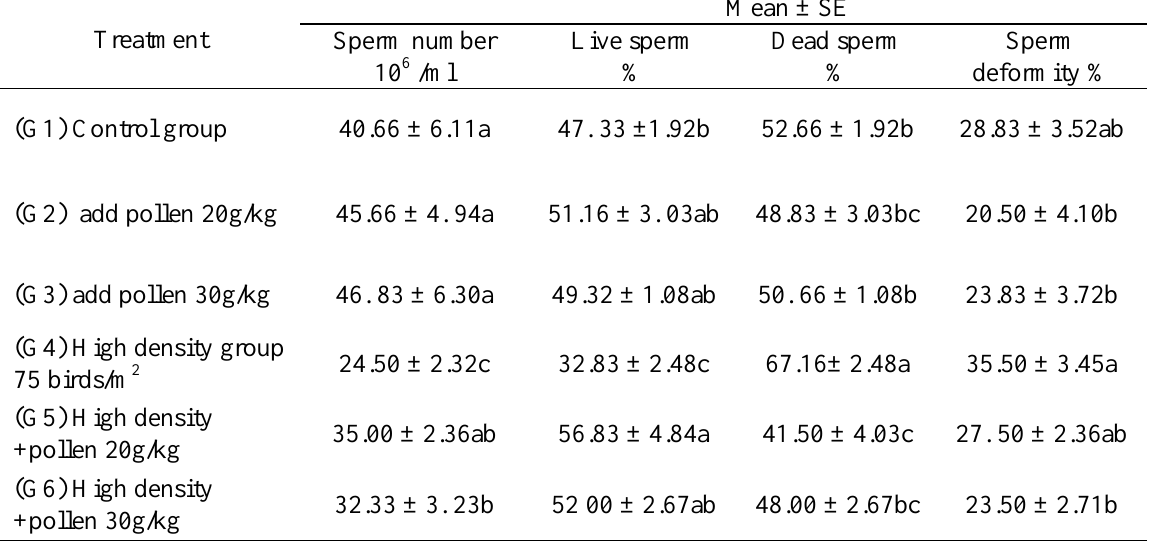
Table 3: Effect of high density of bird numbers and the addition of bee pollen to the diet on the spermatogenesis of quail